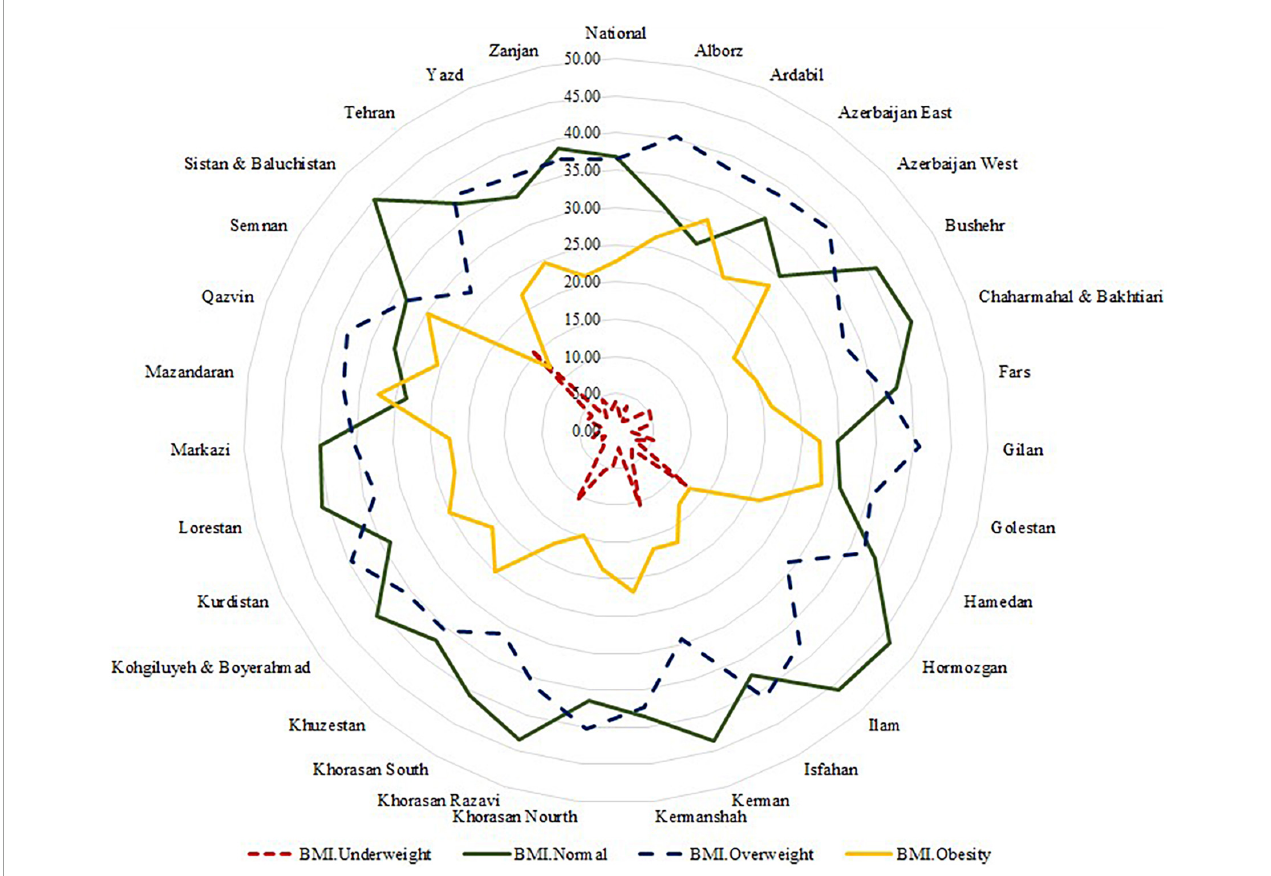
FIGURE1 The percent of national and provincial prevalence of underweight, normal, overweight, and obesity from the Stepwise approach to surveillance (STEPS) 2016 study in Iran. The red line (---) is expressed as a percentage of underweight, green line (—) prevalence of normal weight, blue line (––) prevalence of overweight and yellow line (—) prevalence of obesity across Iran’s provinces. In the provincial level, lowest prevalence of overweight and obesity was seen in Sistan and Baluchistan (26.91% and 12.26, respectively) and highest was seen in Isfahan (40.97%) and Mazandarazn (32.28%),